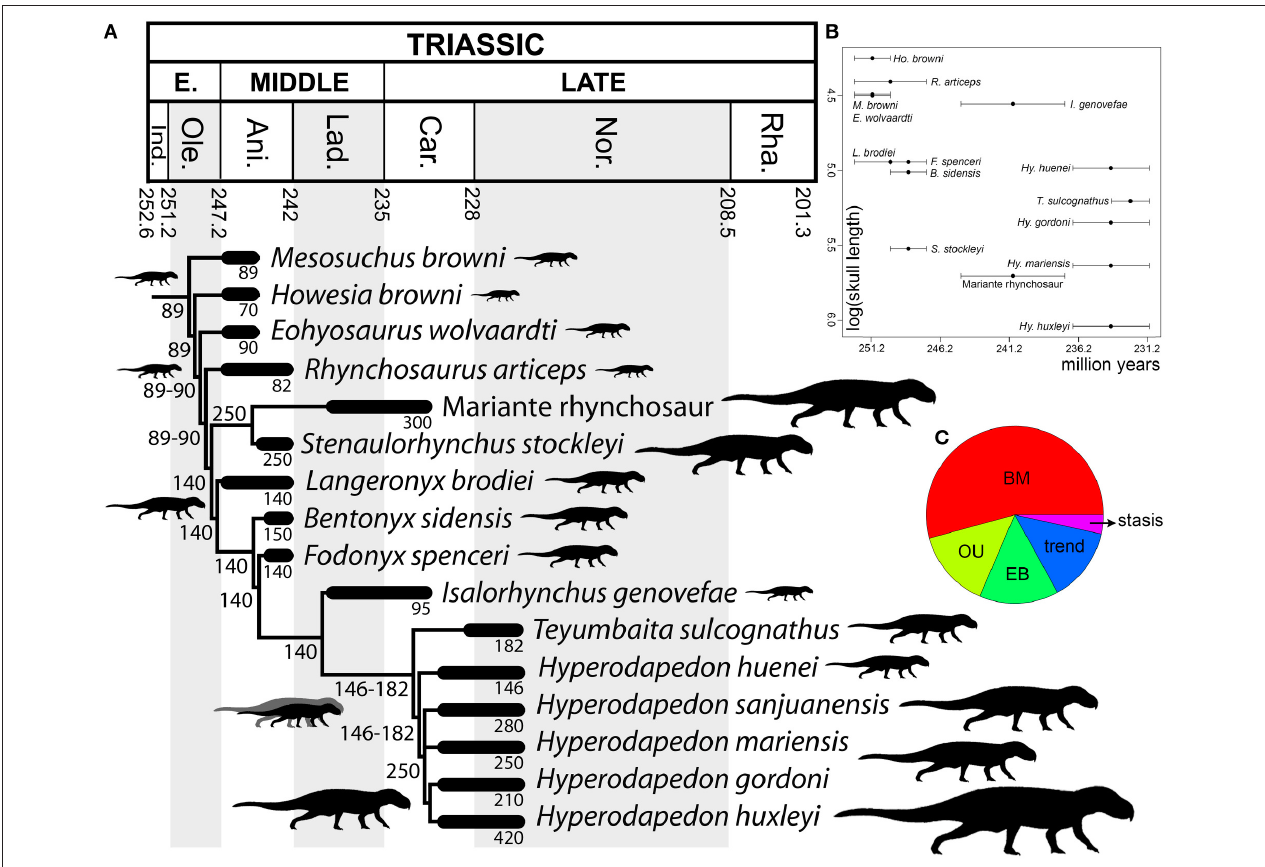
FIGURE 10 | Body size analyses results. Time-calibrated informal supertree showing the optimization of skull length through rhynchosaur evolution (A) , bivariate plot showing log (skull length) vs. temporal calibration of taxa (horizontal error bars indicate chronostratigraphic uncertainty) (B) , and relative support for evolutionary model fit analysis using mean ages (C) . Abbreviations: Ani, Anisian; BM, Brownian motion; Car, Carnian; EB, Early Burst; Ind, Induan; Lad, Ladinian; Nor, Norian; Ole, Olenekian; OU, Ornstein–Uhlenbeck; Rha,